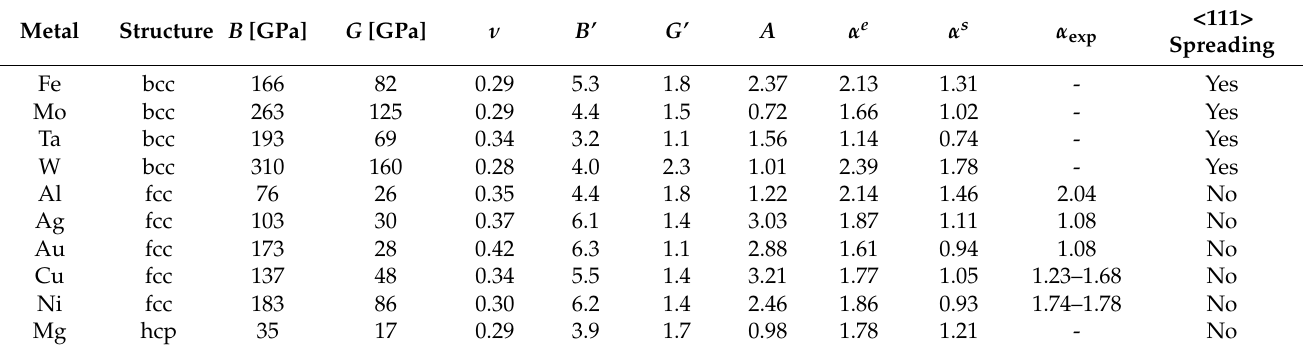
Table 1. Anharmonic volume change factors of dislocations from Equation (15), with elastic properties. Experimental data for α exp from ref. [35] on Al 1100 and from ref. [34] on Ag, Au, Cu, and